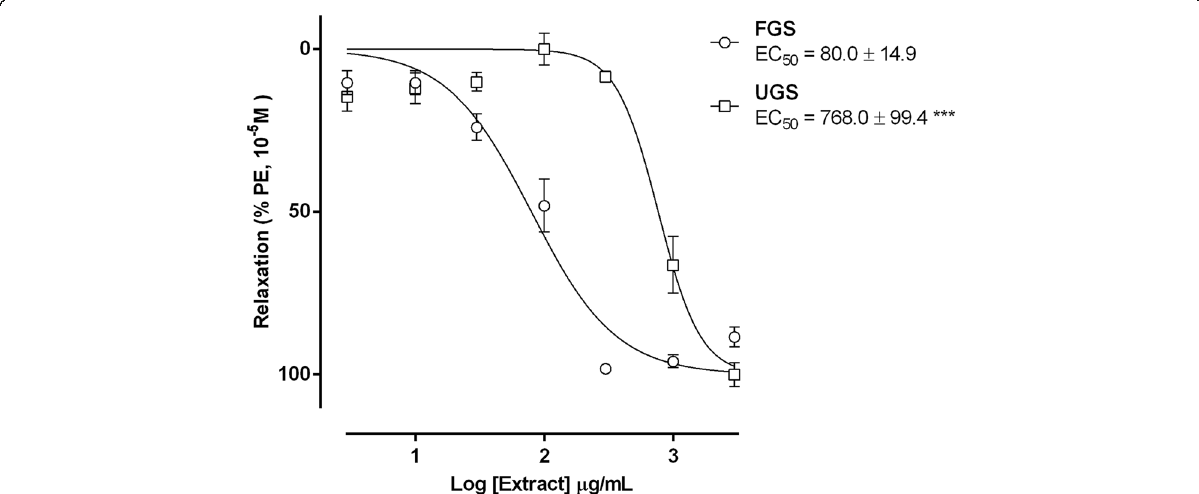
Fig. 1 Vasorelaxant effect induced by fermented (FGS) and unfermented (UGS) grape skin extracts (10 – 3000 μ g/mL). The responses were assessed in endothelium-intact mesenteric artery ring resistance pre-contracted to PE 10 μ M. Data are expressed as mean ± SEM of 5 and 7 experiments, respectively. *** significant when compared to FGS, P <